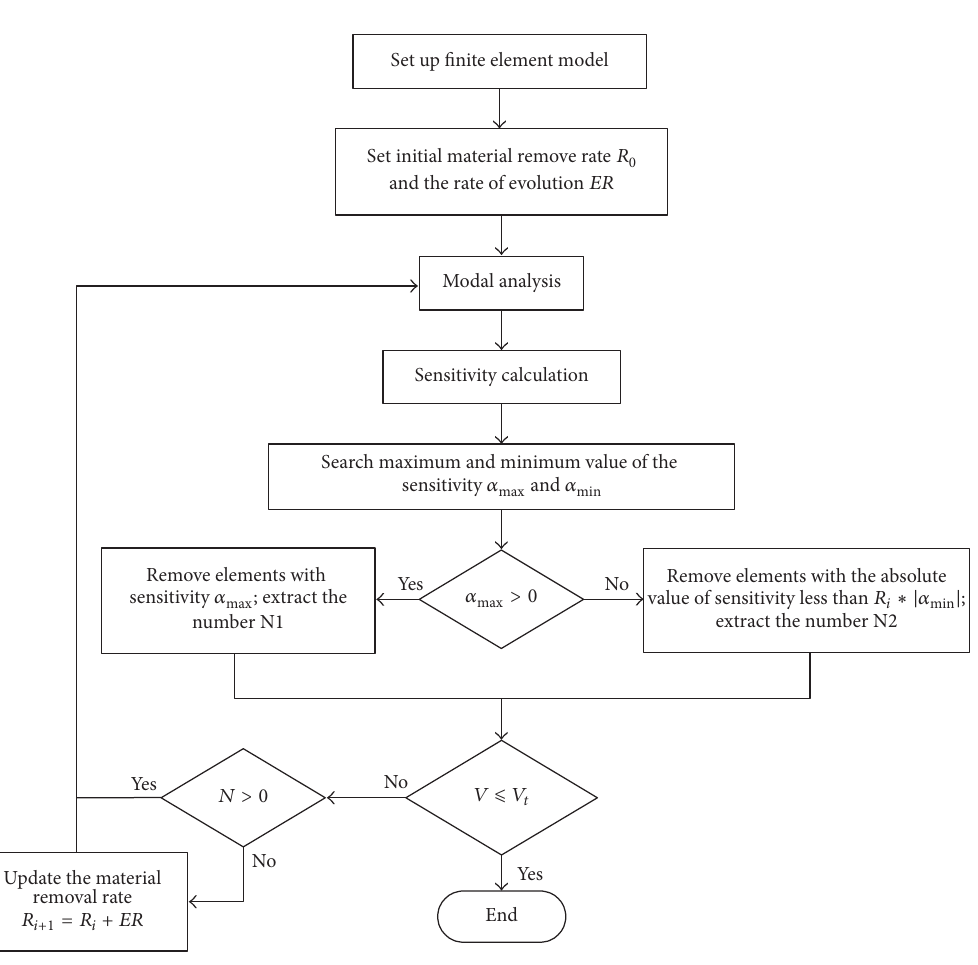
Figure 3: Flow chart of topology optimization process by ANSYS.